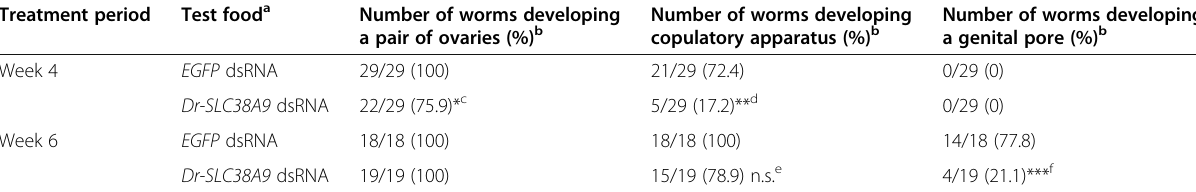
Table 1 Dr-SLC38A9 RNAi knockdown during sexual induction Treatment